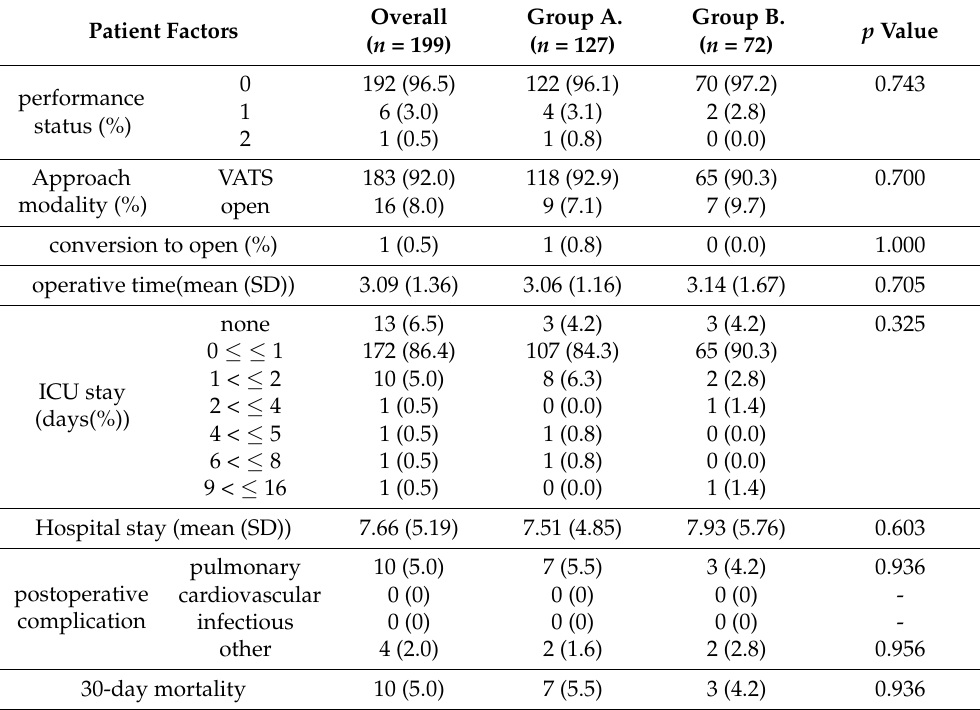
Table 3. Perioperative factors with statistical insignificance between group A and group B. Patient